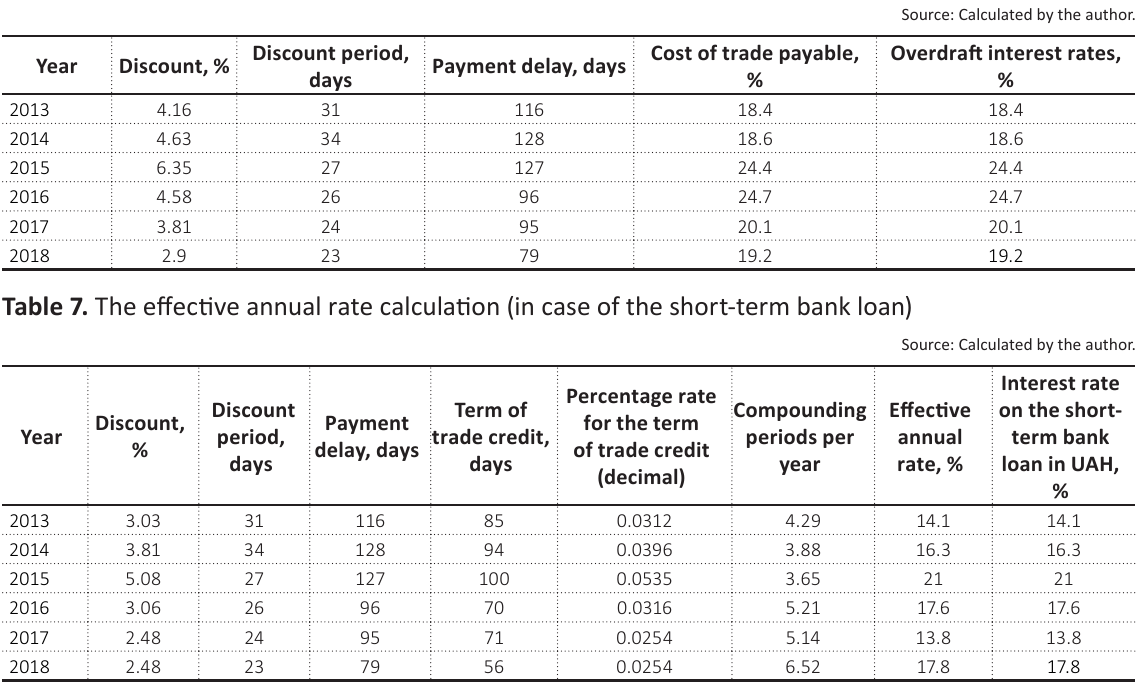
Table 5. The cost of trade credit based on the failed discount